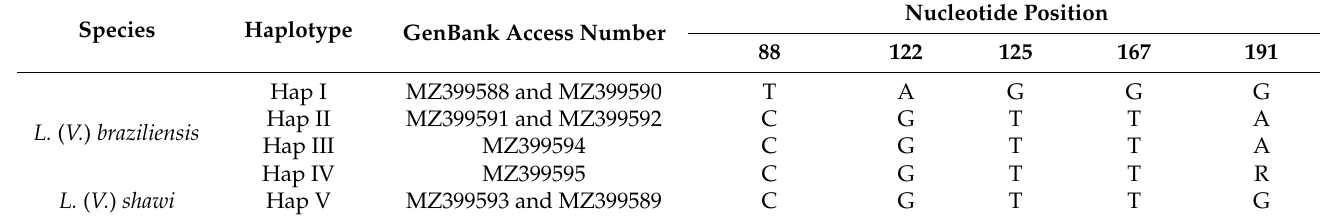
Table 3. Haplotypes of Leishmania species for the hsp70-234 gene.